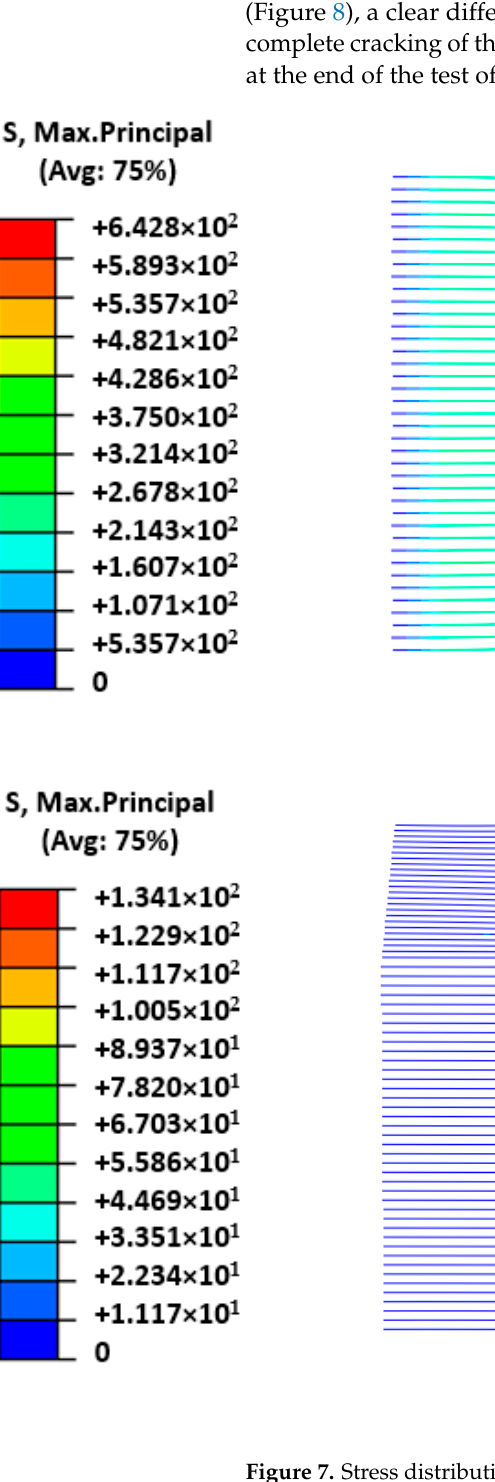
Figure 7. Stress distribution in the wire in the maximum load.